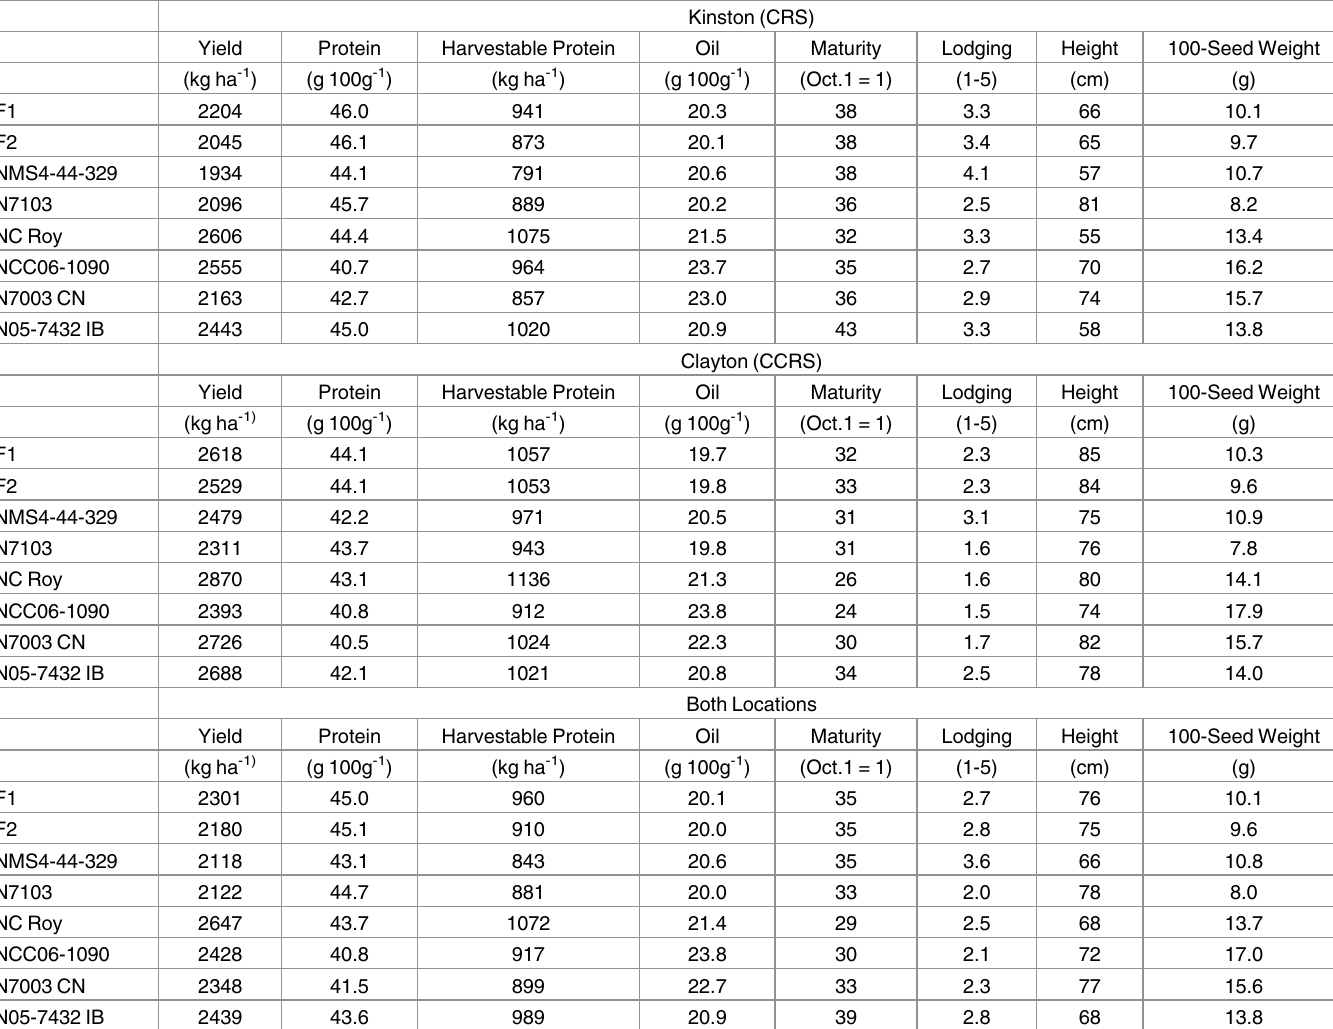
Table 2. Agronomic